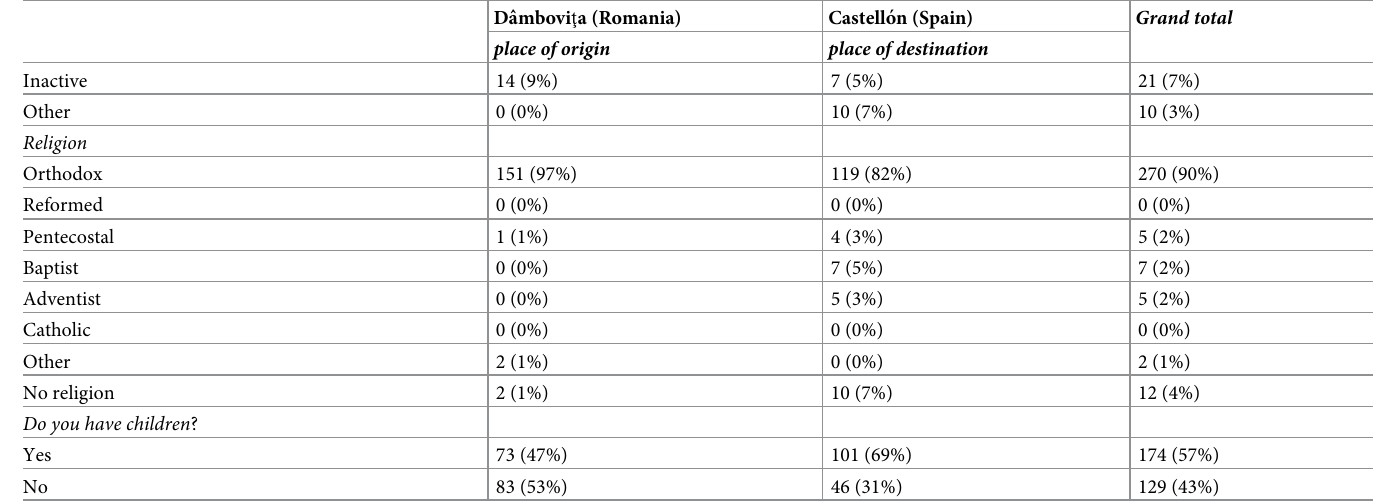
Negative E-I index scores indicate homophily. Fig 5 shows that throughout the link-tracing network there are both sex and place of residence tendencies toward homophily. Working with the observed values (frequencies) for detecting homophily has two potential validity threats [11]: nominations are conditioned by the relative number of people in each cat- egory ( e . g ., number of females versus number of males, respondents living in Daˆmbovi ț a ver- sus respondents living in Castello´n) and by the volume of referrals ( i . e ., the number of referrals variates across referees). To manage these potential validity threats, we performed permutation tests to assess whether the observed link-tracing network E-I index score on a specific attribute (sex and residence) is significantly higher or lower than the score expected by chance.